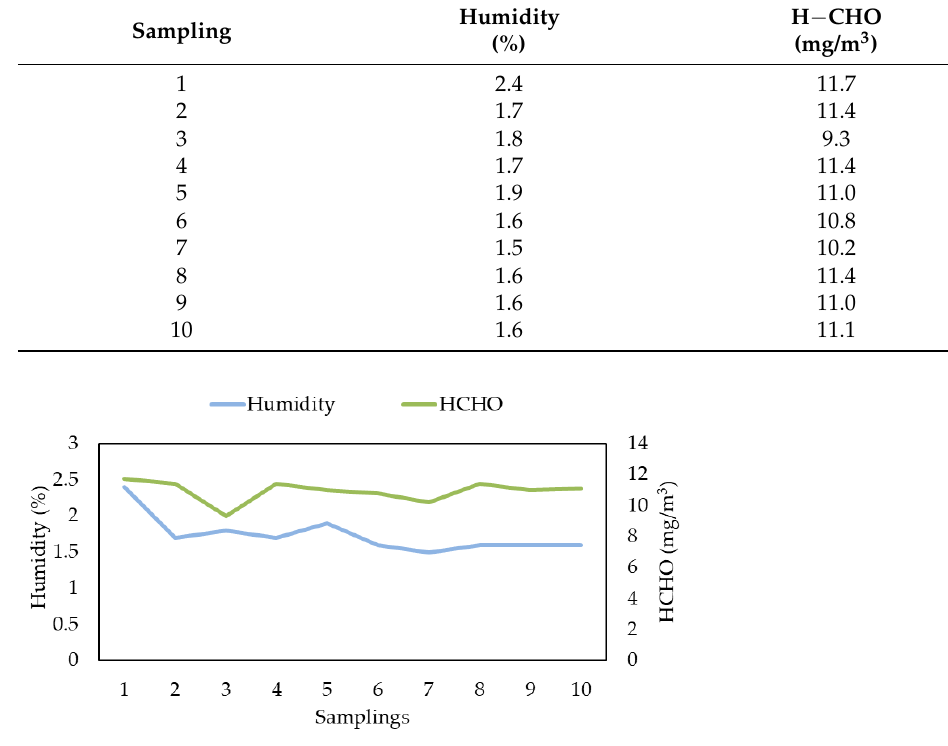
Table 7. Humidity and H − CHO obtained by Lab. RSE. during Second Campaign. Sampling